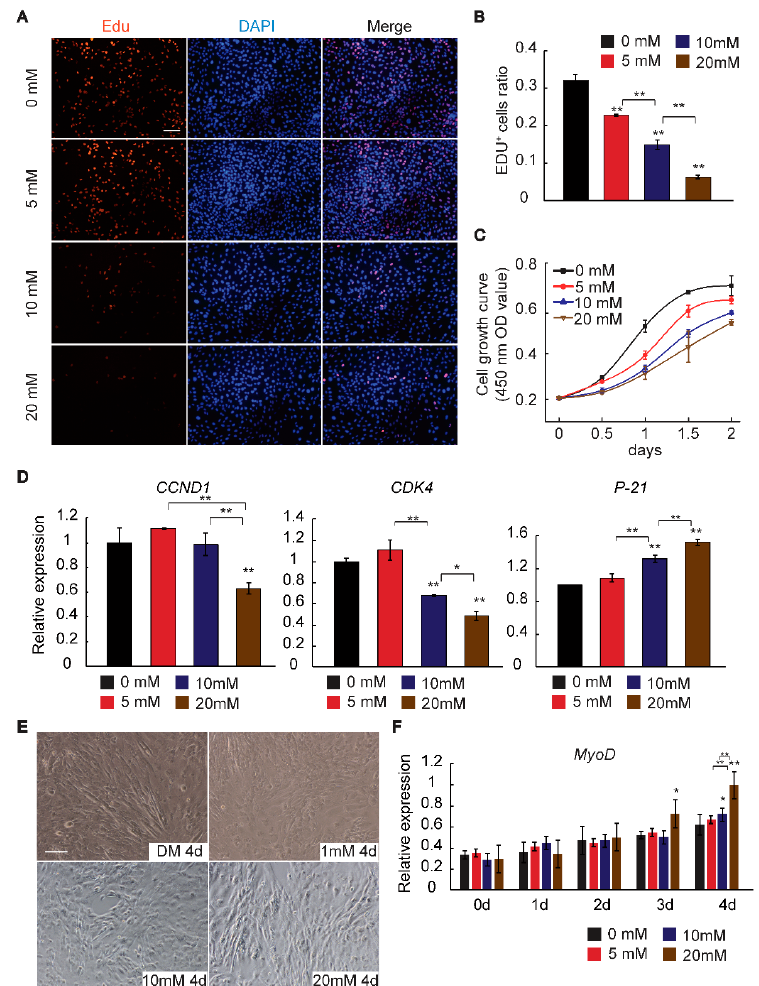
Figure 1. Effect of Guanidinoacetic Acid (GAA) on proliferating myoblasts. Myoblasts were cultivated in growth medium (GM) or differentiation medium (DM) in the presence of 0, 5, 10, or 20 mM GAA. ( A , B ) EdU analysis showed that GAA significantly reduced the cell proliferation ratio; ( C ) CCK-8 tests indicated that cell growth was suppressed by GAA in a dose-dependent manner; ( D ) relative expression of marker genes of proliferation, including Cyclin D1 ( CCND1 ), Cyclin Dependent Kinase 4 ( CDK4 ) and Cyclin Dependent Kinase Inhibitor 1A ( P21 ) after treatment with the concentration gradient of GAA; ( E ) images were obtained by brightfield microscopy on the fourth day of myoblast differentiation after stimulation with the concentration gradient of GAA; ( F ) the relative expression of myogenic differentiation 1 ( MyoD ). The results are expressed as mean ± S.D. of three independent experiments. * p < 0.05; ** p < 0.01 compared with the negative control (on the bars) or between the indicated groups (Tukey’s post-hoc test).